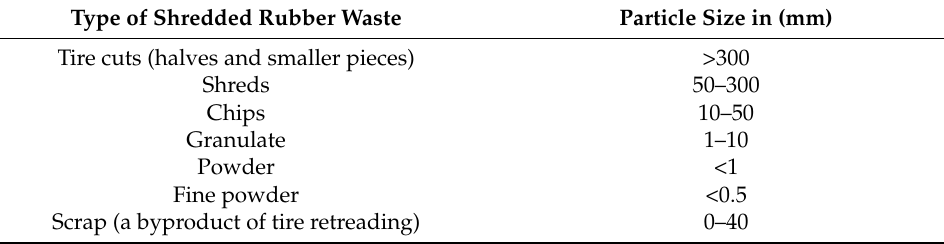
Table 1. Classification of materials obtained from waste tires according to EN-14243 [8].